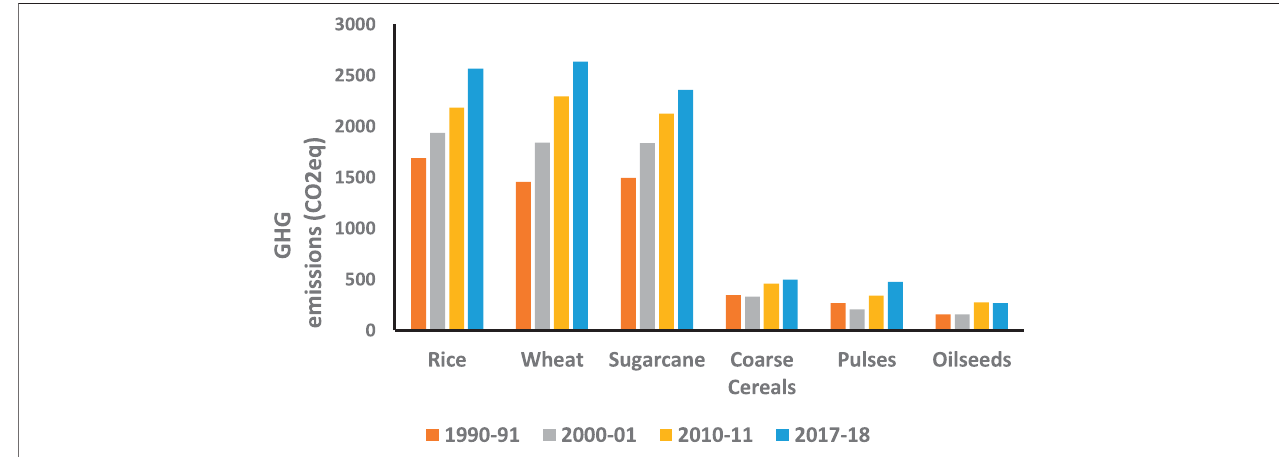
FIGURE 4 | Total amount of GHG emissions from crop residue burning (CO 2 equivalent). Note: GHG emissions from crop residue burning include only CH 4 and N 2 O emissions, as per the IPCC (2006)